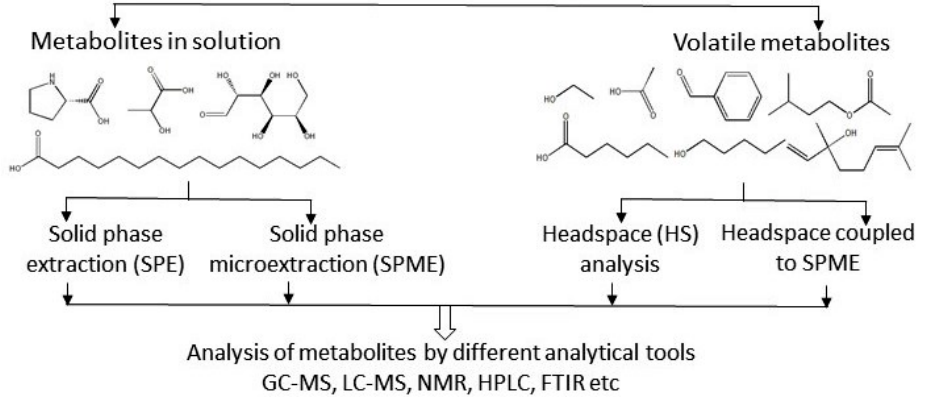
Figure 3. Overview of extracellular metabolite analysis. Different technical methods, such as solid-phase extraction (SPE), solid-phase micro extraction (SPME), head space (HS) analysis, and HS-SPME, are used for the preparation of extracellular samples. Sample preparation protocols depend on the type of metabolite. Here, GC-MS = gas-chromatography coupled to mass spectrometry; LC-MS = liquid-chromatography coupled to mass spectrometry; NMR = nuclear magnetic resonance spectroscopy; HPLC = high pressure liquid chromatography; FTIR = Fourier transform infra-red spectroscopy.